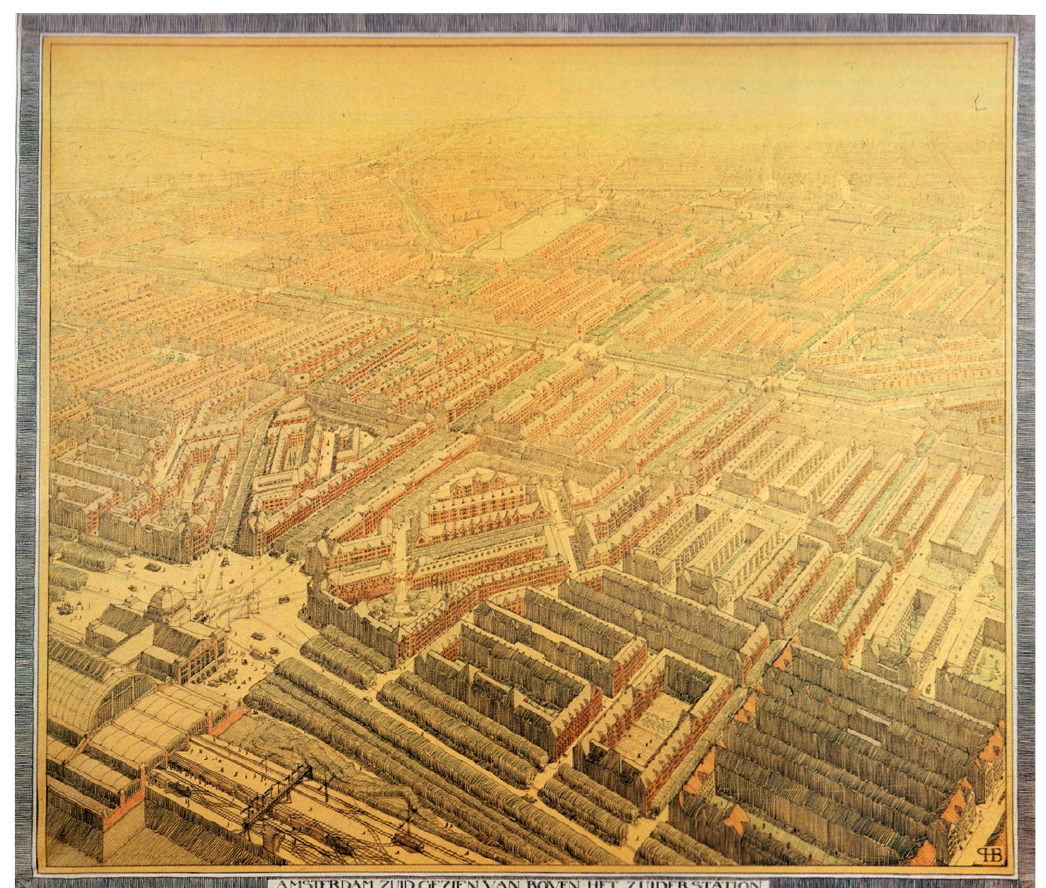
Figure 1. H. P. Berlage, aerial view of the project for south Amsterdam, 1915. Source: Gemeente Amsterdam Stadsarchief